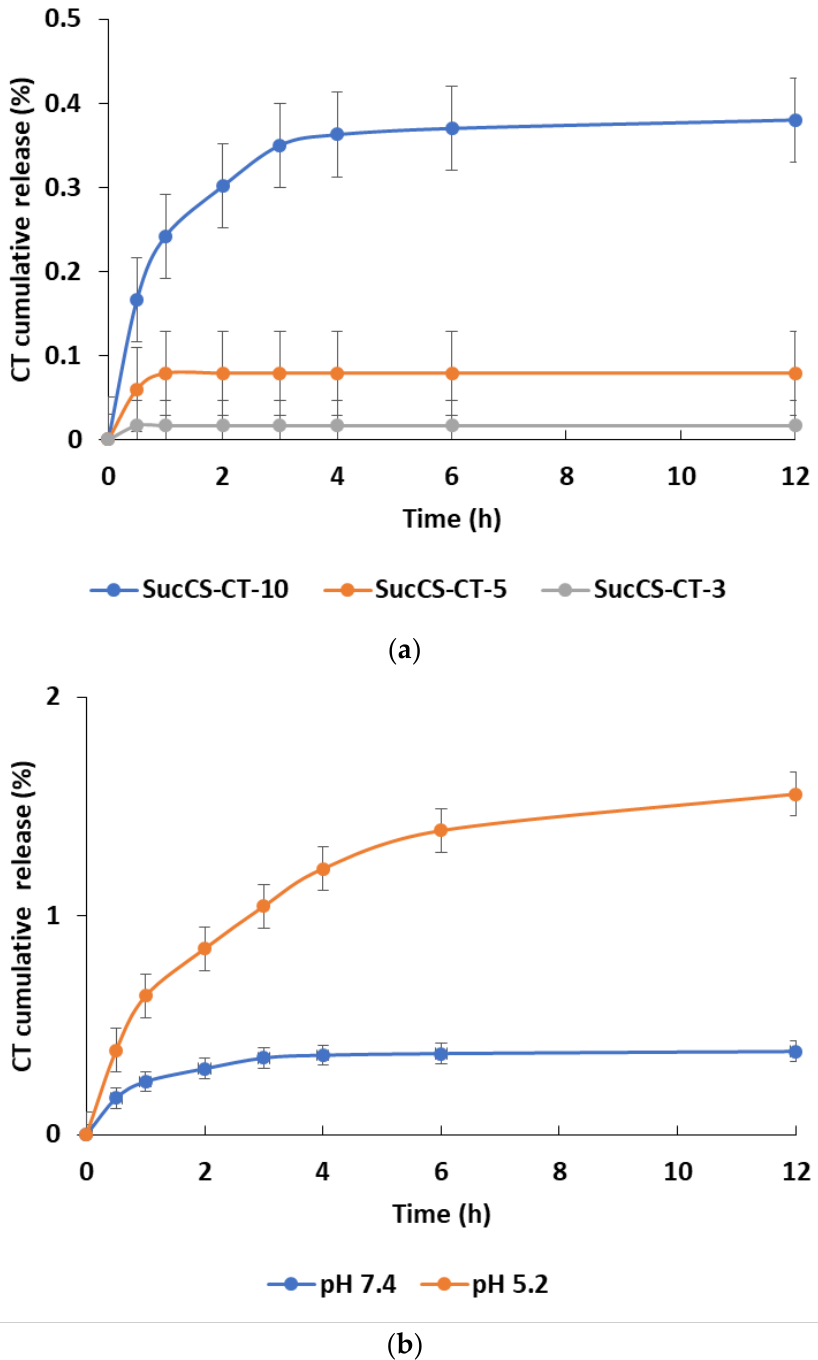
Figure 5. Colistin (CT) release kinetics at 37 °C from the succinyl chitosan-colistin conjugates (SucCS-CT-3, SucCS-CT-5, SucCS-CT-10) in PBS, pH 7.4 ( a ) and from SucCS-CT-10 in phosphate buffer, pH 5.2 ( b ). Each point represents the average of triplicate measurements ± SD.